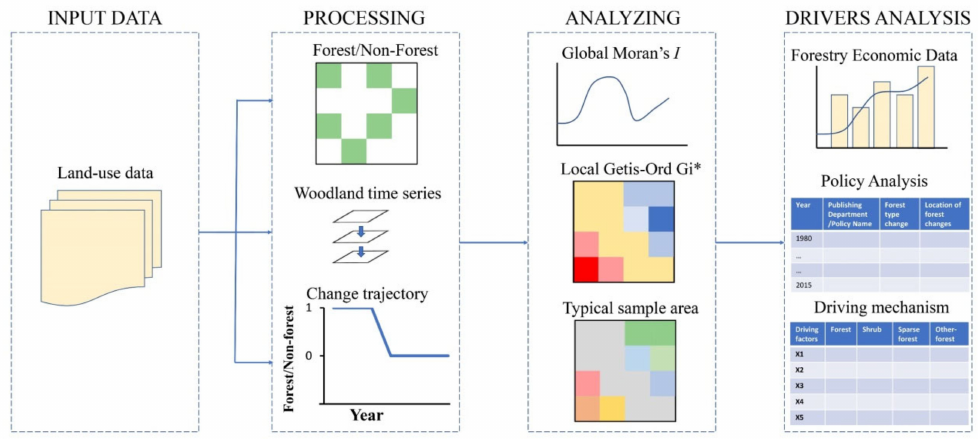
Figure 2. A graphical outline of the research